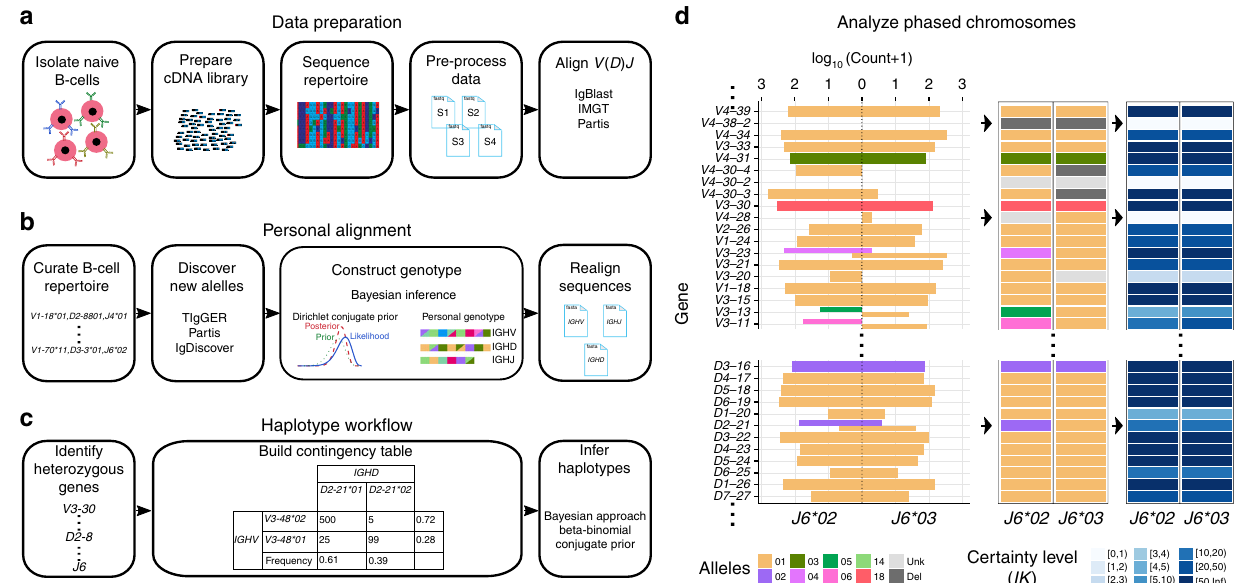
Fig. 1 Schematic view of the haplotype inference process. a Naive B-cells are fi rst isolated, followed by RNA puri fi cation. cDNA libraries are prepared, sequenced, the resulting data are pre-processed, and initial VDJ alignment is performed. b Novel alleles are discovered, and the genotype is constructed. An additional VDJ alignment is performed using the constructed genotype. c Contingency tables are constructed for J-V/J-D/V-D heterozygous gene pairs, and the haplotype is inferred using a Bayesian approach (see Methods). d The output can be presented as a phased chromosomes graph. The left panel shows the count of each gene ( Y axis) that is associated with its paired anchor gene ( X axis). In this example the anchor gene is J6 , and the inferred haplotypes are the V/D genes. Colors correspond to the different alleles. The thickness of the count bar is inversely proportional to the number of alleles found on the chromosome. The middle panel shows the called V/D haplotype, and the right panel shows the certainty level ( lK ) for each haplotype decision. The full haplotype output for the individual in this example is shown in Fig.